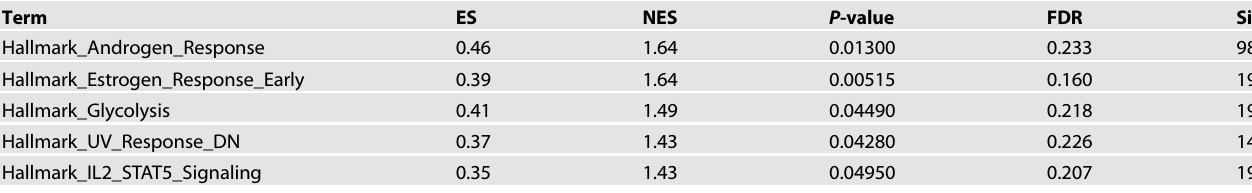
Table 3. Top hallmark gene sets ( P < 0.05 and FDR < 0.25) enriched in GHR group.